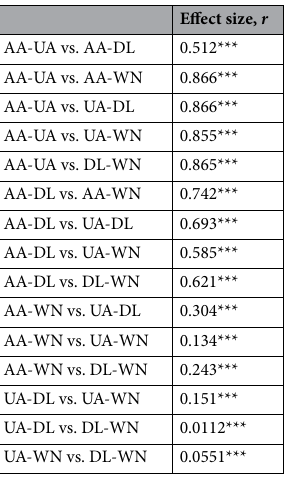
Table 2. Results of the Bonferroni-corrected Mann–Whitney U test to compare all 15 pairs of carriers in terms of d . *** p < 0.001 .